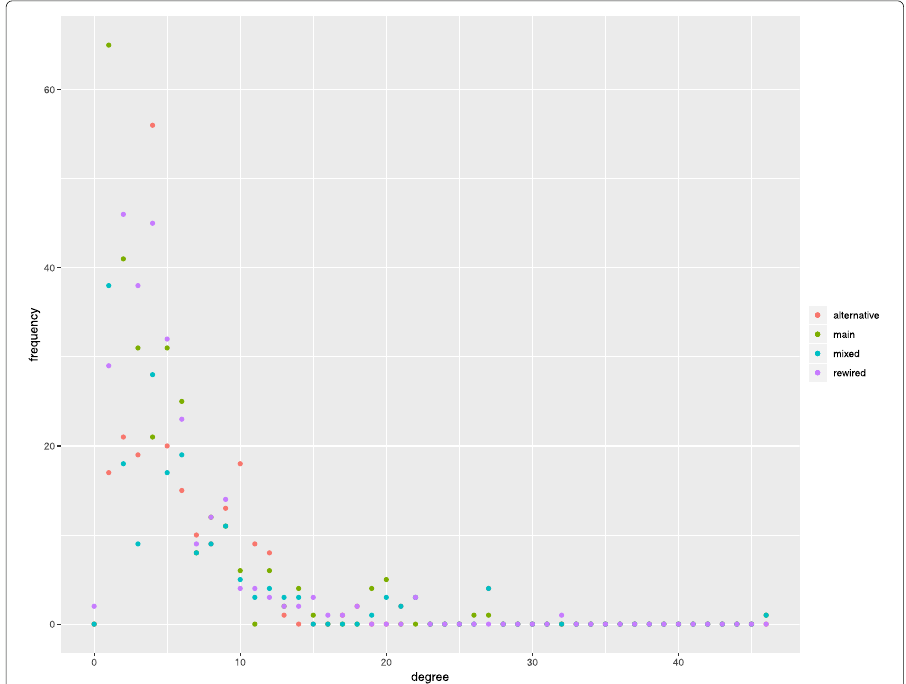
Fig. 3 Degree frequency for the four networks analyzed in this